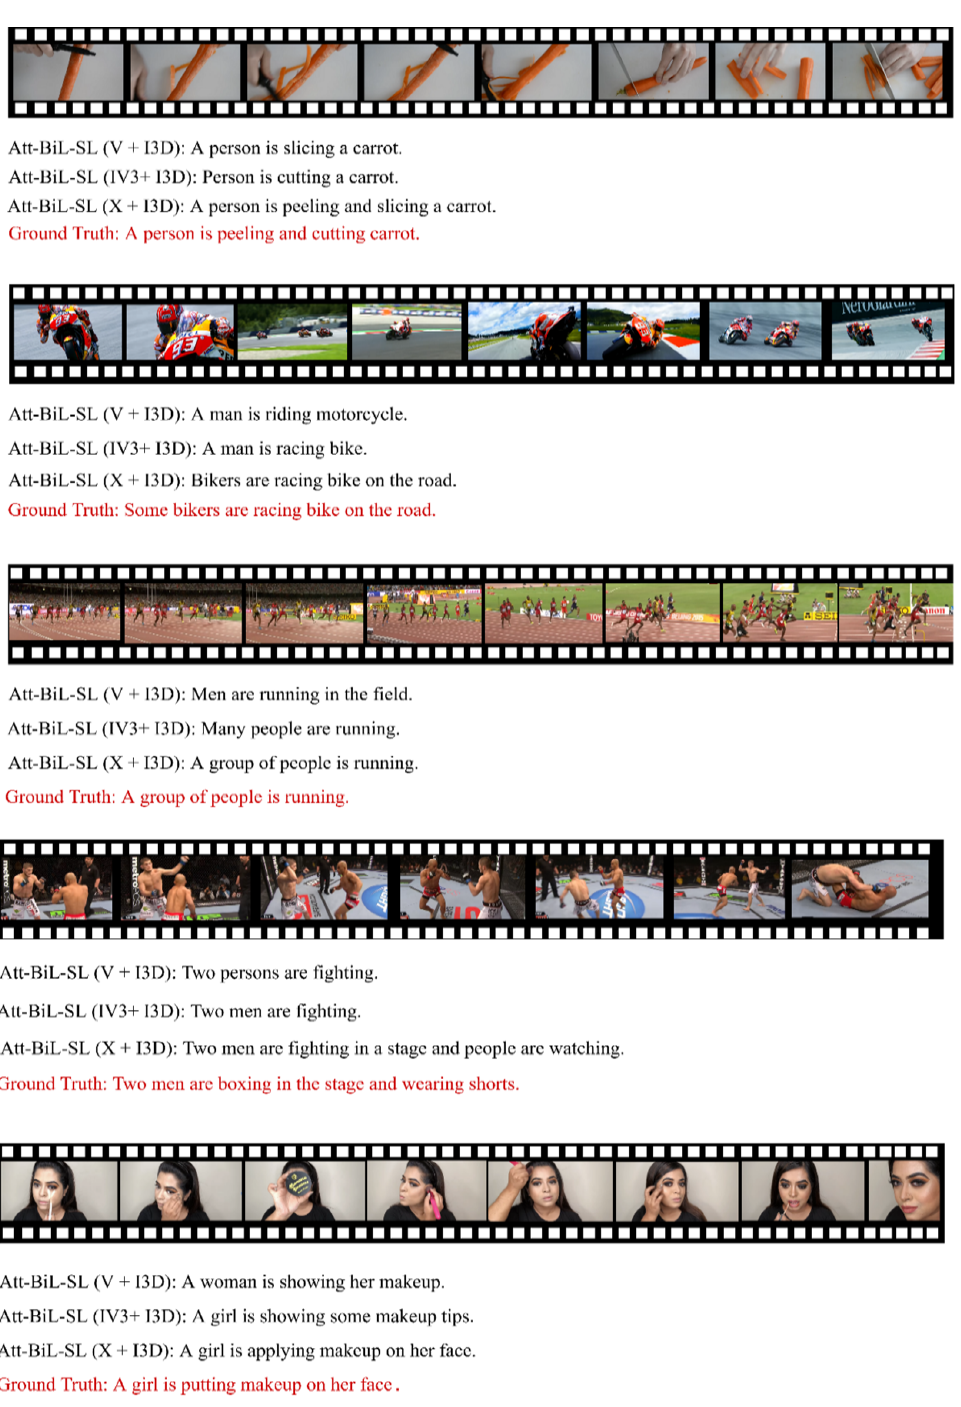
Figure 4. The sentence generation of our proposed model from several testing videos. Here, V, IV3, X, and I3D denote the VGG-16, InceptionV3, Xception, and Inflated 3D network individually. We compared the generated sentences with the human-annotated ground truth (GT) sentences.